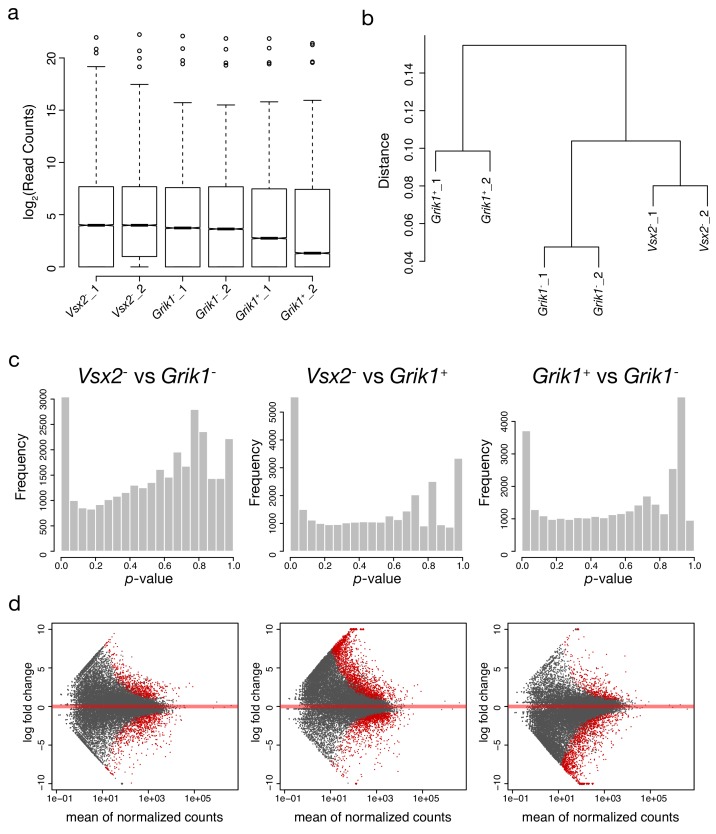
Quality control of mouse Probe-Seq RNA sequencing.(a) Log2-transformed read distribution plot for sequenced mouse Vsx2/Grik1 Probe-Seq samples. (b) Dendrogram of read counts shows clustering of Vsx2-, Grik1-, and Grik1+ samples. (c) Plots of frequencies of p-values shows an even distribution of null p-values. (d) MA plots of log2 fold change vs. mean of normalized counts. Red dots indicate genes that are differentially expressed.